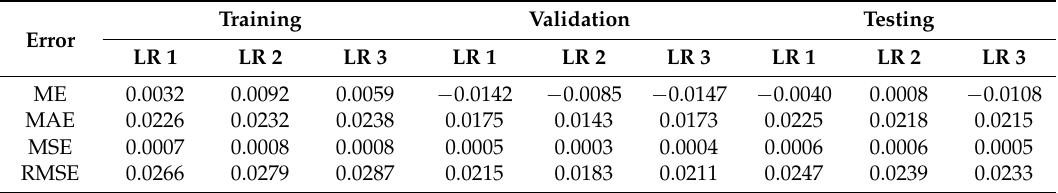
Table 9. Statistical analysis of different models of LR in the training, validation, and testing phases.